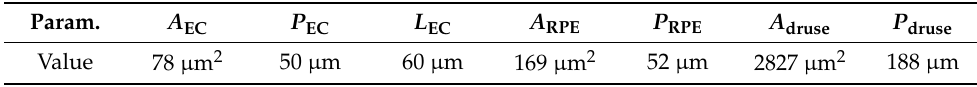
Table 1. Target areas, perimeters and